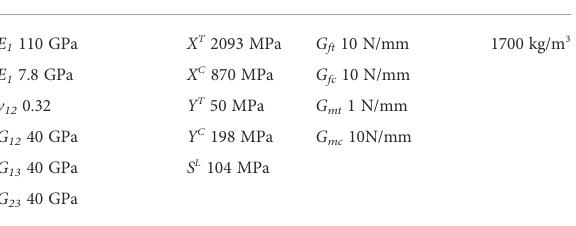
TABLE 1 Mechanical parameters of composite. Elastic properties